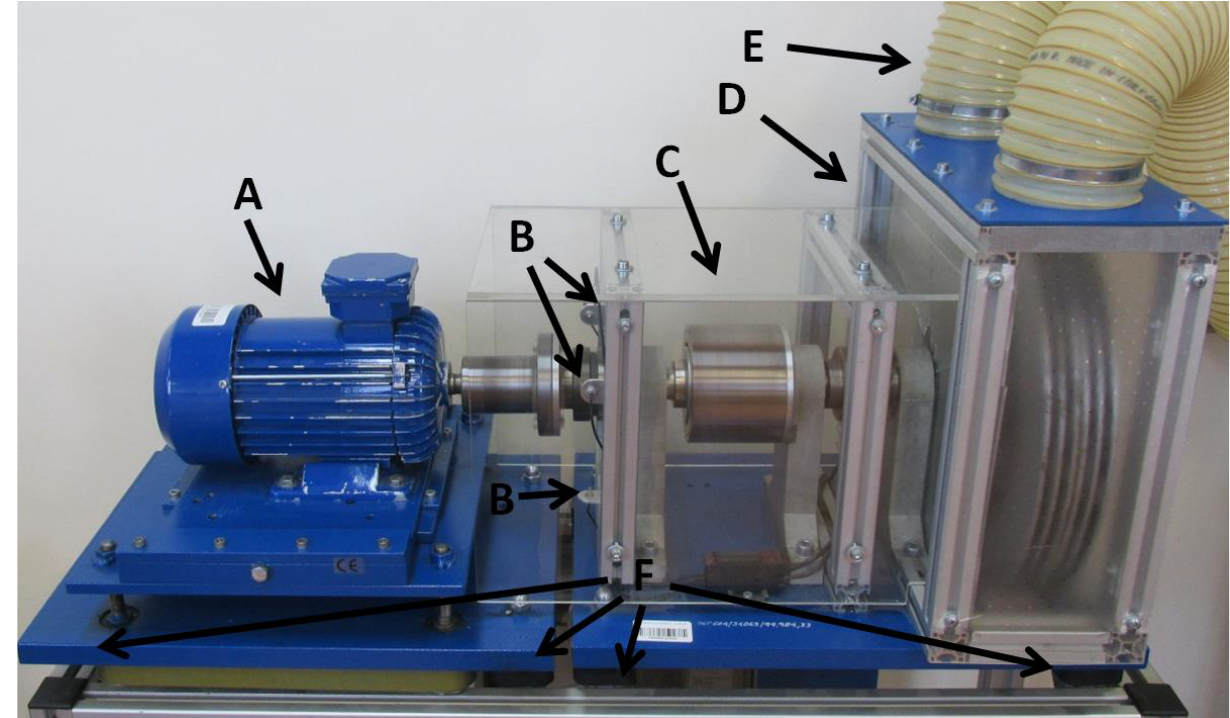
Figure 1. Experimental test rig.